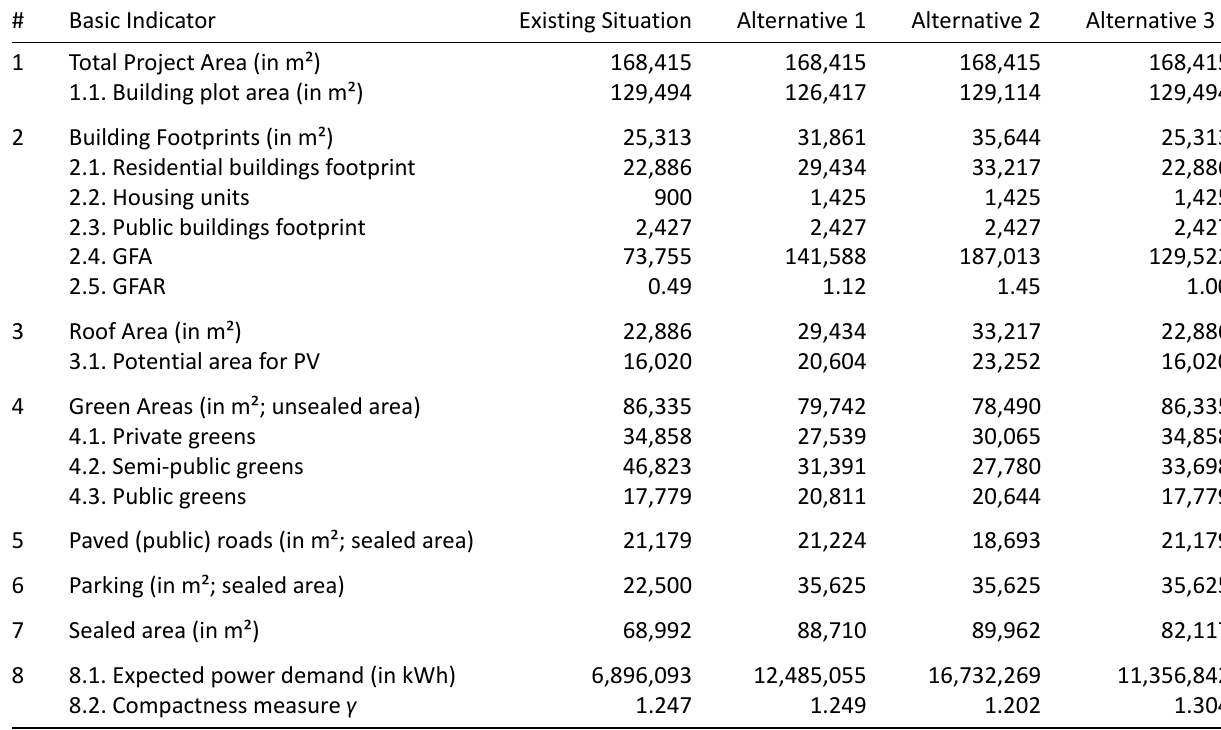
Table 3. Results: Basic indicators.